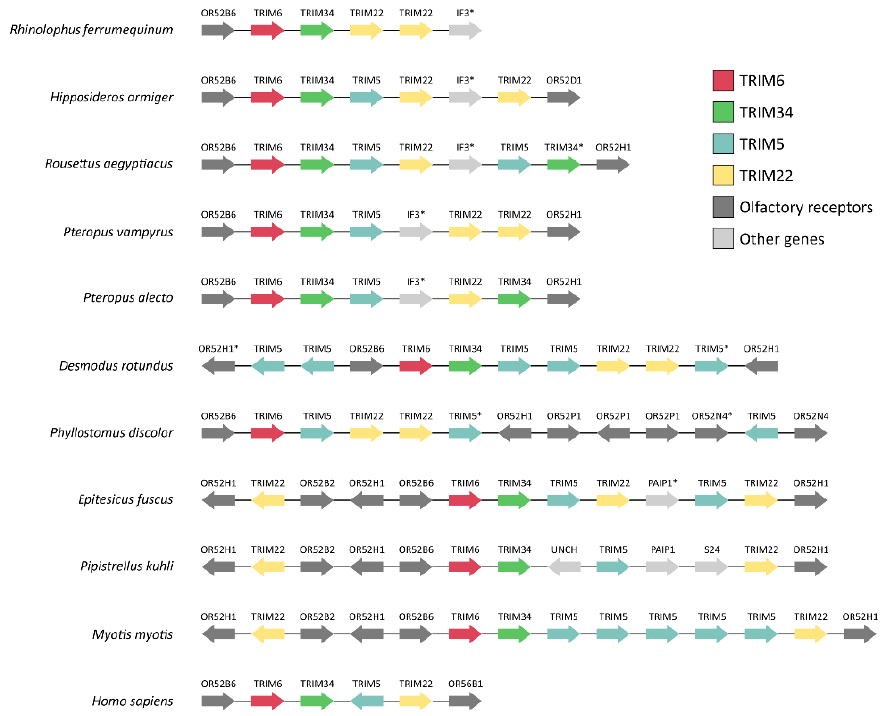
Figure 4. Synteny map of the TRIM6 / 34 / 5 / 22 gene cluster of members of the Chiroptera order. Synteny comparisons of the TRIM6 / 34 / 5 / 22 gene cluster of bats show very low conservation of this region of the genome among species. The human homologous gene cluster is shown at the bottom for comparison. Asterisks (*) indicate loci annotated as pseudogenes.